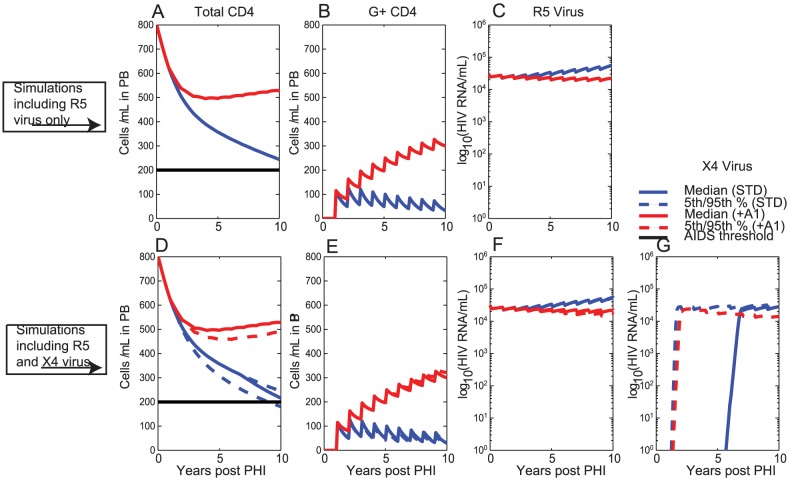
Repeated annual delivery of gene therapy to CD4+T cells assuming that 20% of CD4+T cells receive the gene construct every year from year 1 (i.e. every year, starting from year 1, 20% of G- CD4+T cells become G+ CD4+T cells).Therapy is first administered at year 1 and then annually thereafter. Shown are the simulation outcomes under the standard scenario (STD) and also under Assumption +A1 of reduced bystander apoptosis in G+ CD4+T cells (+A1); Solid lines denote median values, dashed lines denote 5th and 95th percentiles for outcomes when ×4 virus can develop. Also shown is the AIDS threshold of 200 cells/ µL (solid horizontal black line); A) Total CD4+T cell count, B) G+ CD4+T cell count and C) R5 Viral Load for a single simulation with R5 virus only (i.e. assuming  throughout the course of infection); D) Total CD4+T cell count, E) G+ CD4+T cell count F) R5 Viral Load and G) ×4 Viral Load for Monte Carlo simulations assuming initial infection with R5 virus, but now including ×4 virus.